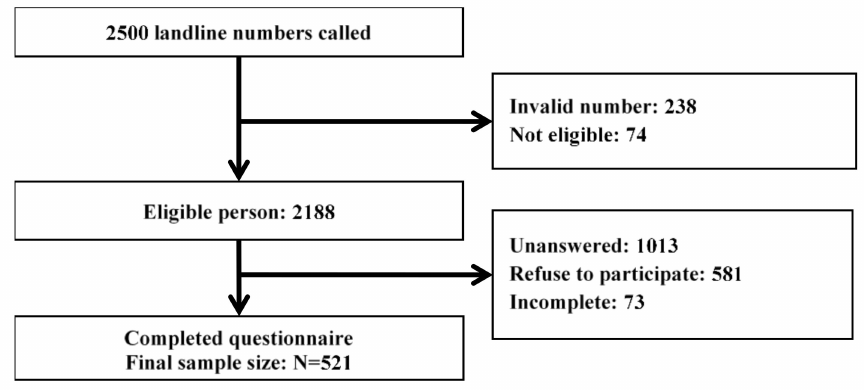
Figure 1. The recruitment details in the telephone